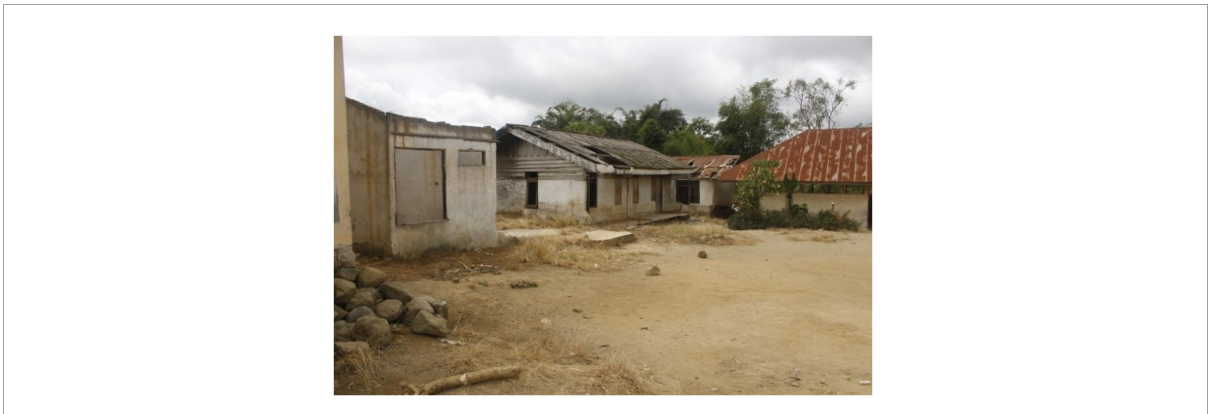
FIGURE1 School buildings destroyed by volcanic